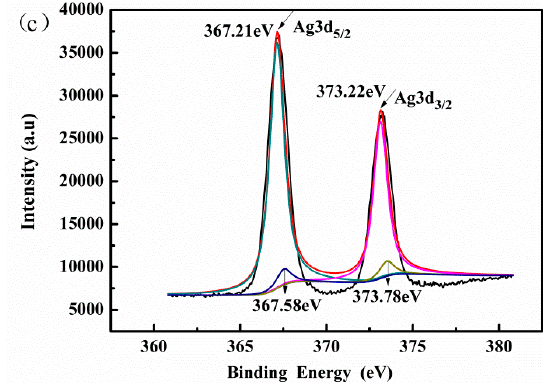
Figure 6. X ‐ ray photoelectron survey spectrum ( a ), Fe 2p spectrum ( b ) and Ag 3d ( c ) spectrum of the Ag/AgCl/MIL ‐ 101(Fe).